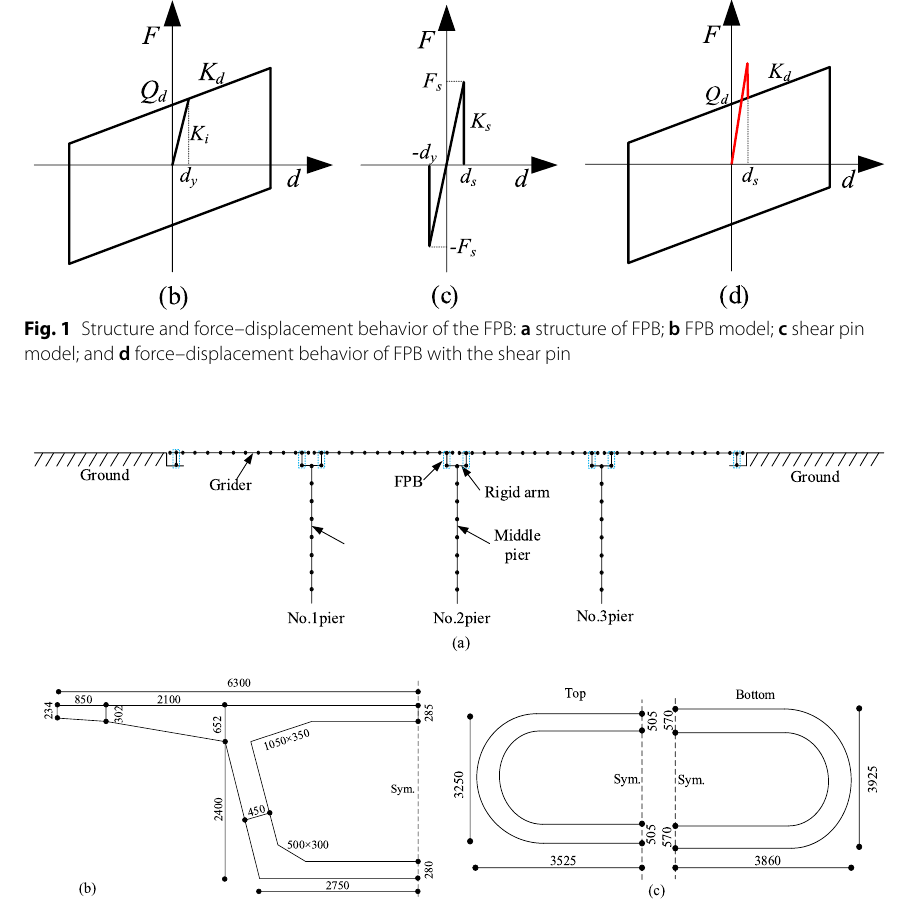
Fig. 2 Case bridge: a simply supported bridge; b girder section; and c pier section (unit in